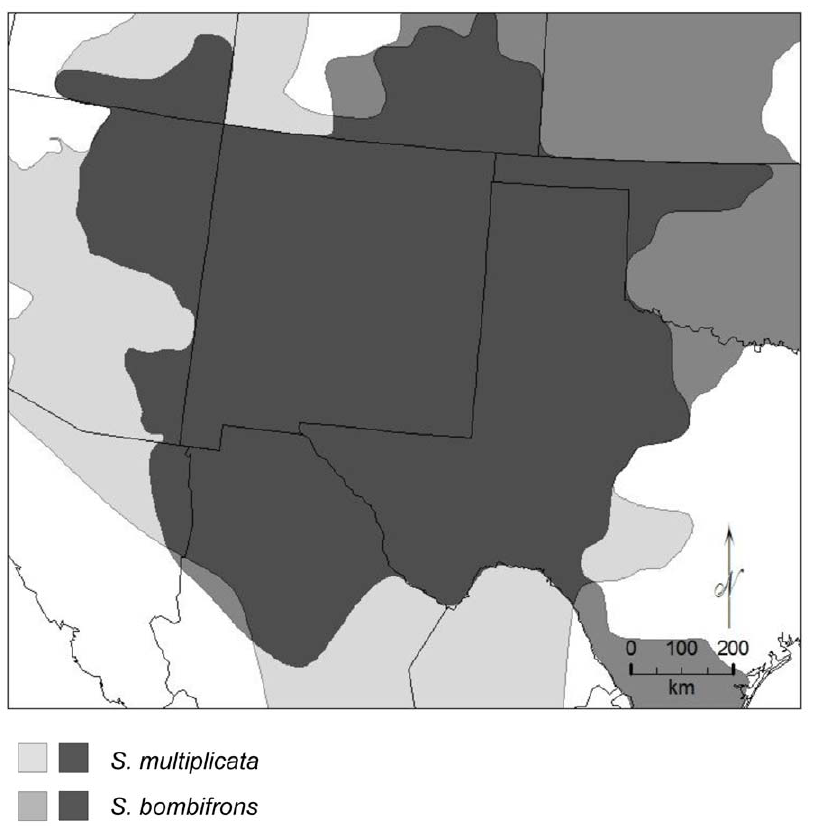
Figure 2. Range maps for Speamultiplicata and S.bombifrons . Range map showing the total range of both S. multiplicata and S. bombifrons .